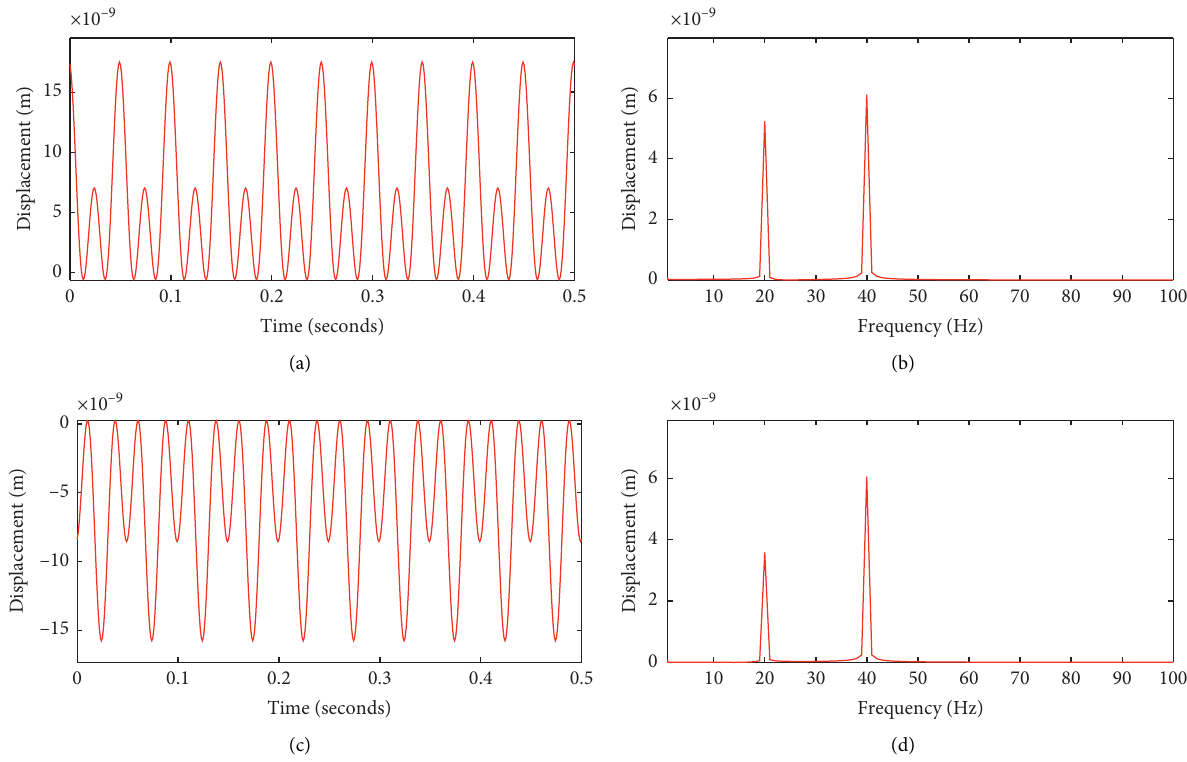
Figure 12: Time- and frequency-domain response in the x directions ( x Time response of y1. (b) Frequency response of y1. (c) Time response of y2. (d) Frequency response of